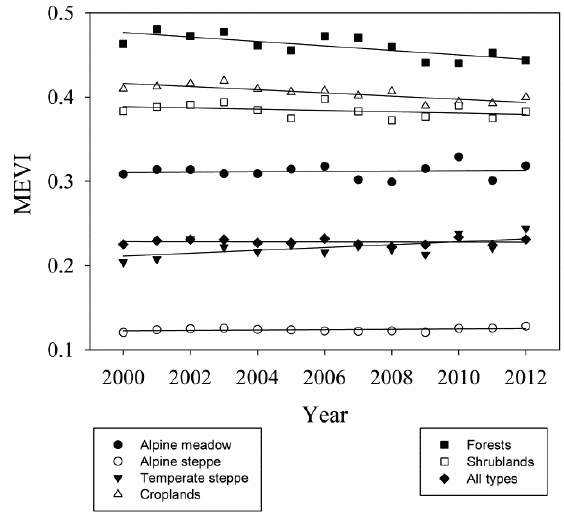
Figure 4. Linear trends for the growing season maximum enhanced vegetation index (MEVI) from 2000 to 2012 over the entire Tibetan